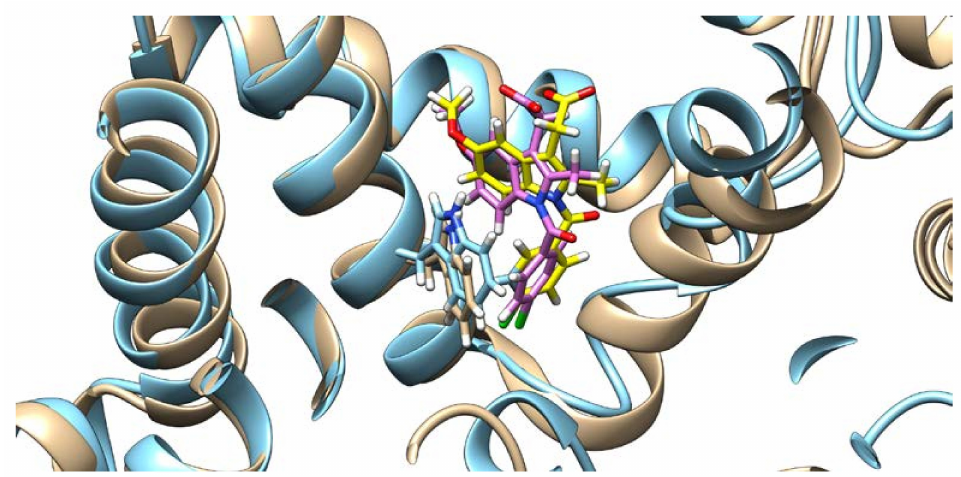
Figure 5. Indomethacin and HSA conformations before (indomethacin is depicted in pink and HSA in brown) and after (indomethacin is depicted in yellow and HSA in light blue) quercetin binding (quercetin is not shown), with the Trp214 shown.